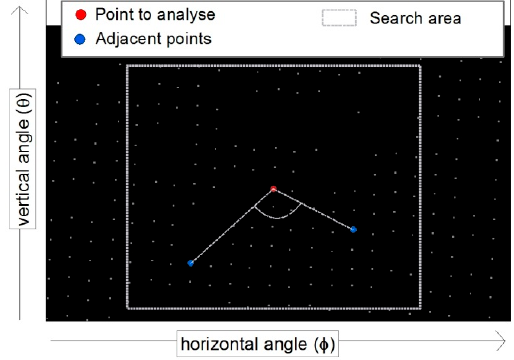
Figure 6. Adjacent points for iterative wedge filtering.